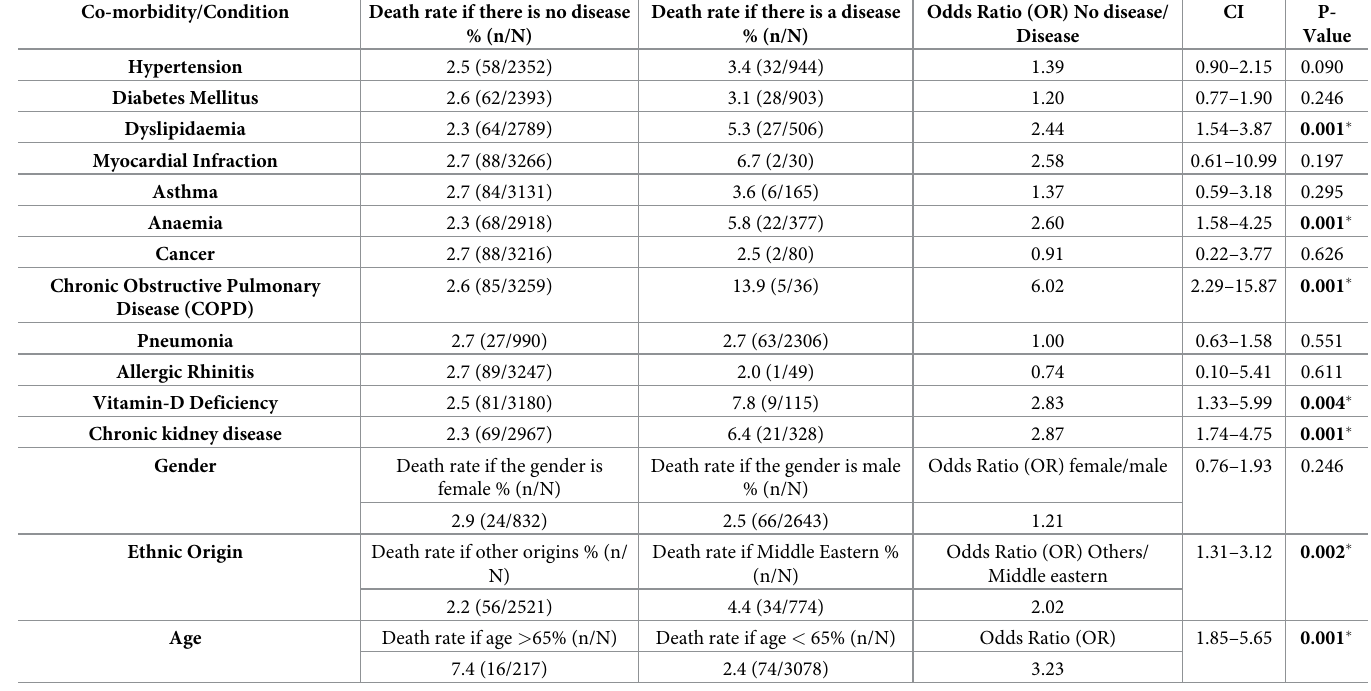
Table 4. Impact of co-morbidities, age, gender and ethnic origin on mortality following COVID-19 infection.